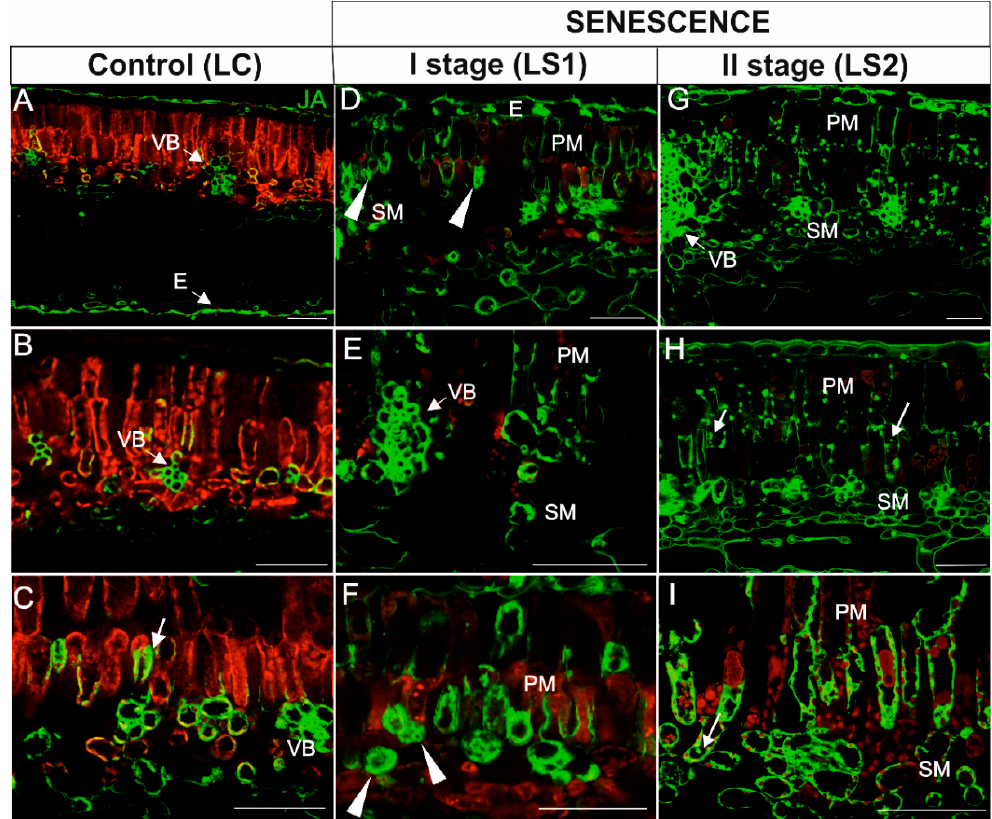
Figure 10. Immunodetection of JA (green fluorescence) and red autofluorescence of chloroplasts in leaves during senescence. ( A – C ) Leaves control (LC); ( D – F ) The first stage of leaf senescence (LS1); ( G – I ), The second stage of leaf senescence (LS2). Abbreviations: VB, vascular bundle; PM, palisade mesophyll; SM, spongy mesophyll; E, epidermis. Scale bars = 50 µm.